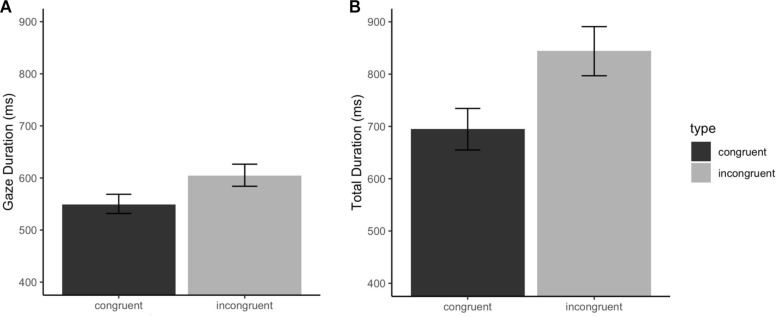
Effect of L1-L2 congruency of the verb on (A) gaze duration and (B) total duration reading times of the verb region. Error bars represent the 95% CI.